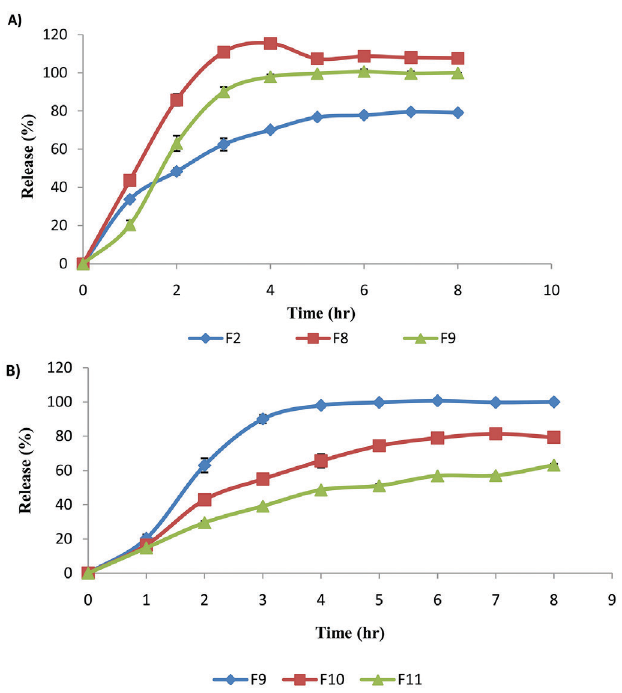
FIGURE 5 - Effect of the molecular weight and concentration of chitosan on the FLB release from chitosan microspheres in PBS: (A) F2 (1% HMw); F8 (1% LMw); F9 (1% MMw); (B) F9 (1% MMw); F10 (2% MMw) and F11 (3% MMw).